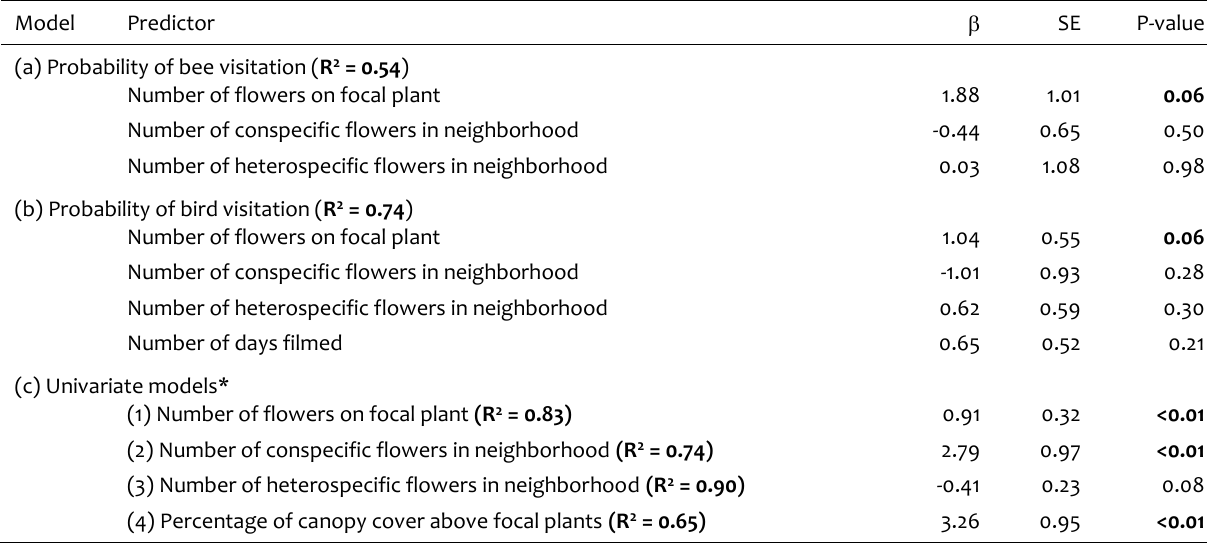
Model results for predictors affecting (a) the probability of bee visitation, (b) the probability of bird visitation, and (c) number of bird